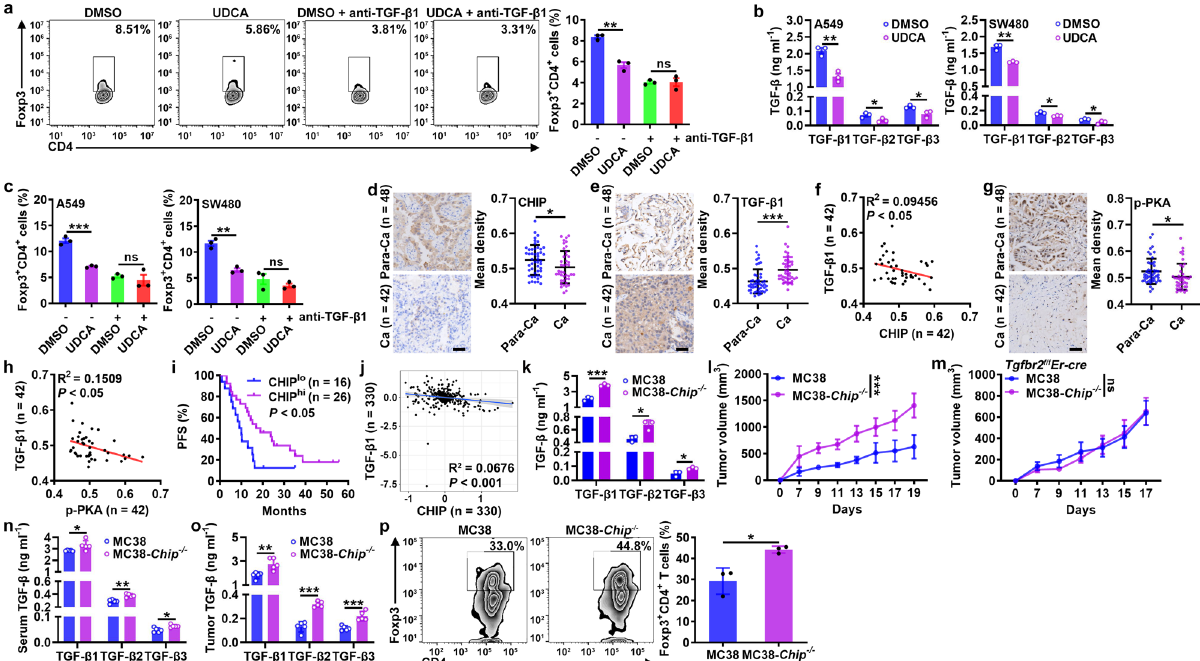
Fig. 6 CHIP inhibits tumor progression by reducing the TGF- β level. a FC analysis of Foxp3 + CD4 + T cells among human naïve CD4 + T cells stimulated with anti-CD3, anti-CD28 and 50 μ M UDCA with or without 2 μ g ml − 1 anti-TGF- β 1 for 4 days. b ELISA of TGF- β 1, TGF- β 2 and TGF- β 3 proteins in supernatants of A549 and SW480 cells treated with 50 μ M UDCA for 24h. c FC analysis of Foxp3 + CD4 + T cells among human naïve CD4 + T cells stimulated with anti-CD3 and anti-CD28 with or without 2 μ g ml − 1 anti-TGF- β 1 and cultured in the supernatants described in b for 4 days. d – h Immunohistochemical analysis of CHIP ( d ), TGF- β 1 ( e ) and p-PKA ( g ) in Para-Ca tissues and Ca tissues ( d , e , g ) and correlations between CHIP and TGF- β 1 ( f ), p-PKA and TGF- β 1 ( h ) protein levels in Ca tissues ( f , h ) of NSCLC patients. i PFS curve for NSCLC patients with low versus high CHIP protein levels. j Correlation between CHIP and TGF- β 1 protein levels in Ca tissues of HCC patients from the CPTAC database. k ELISA of TGF- β 1, TGF- β 2, and TGF-